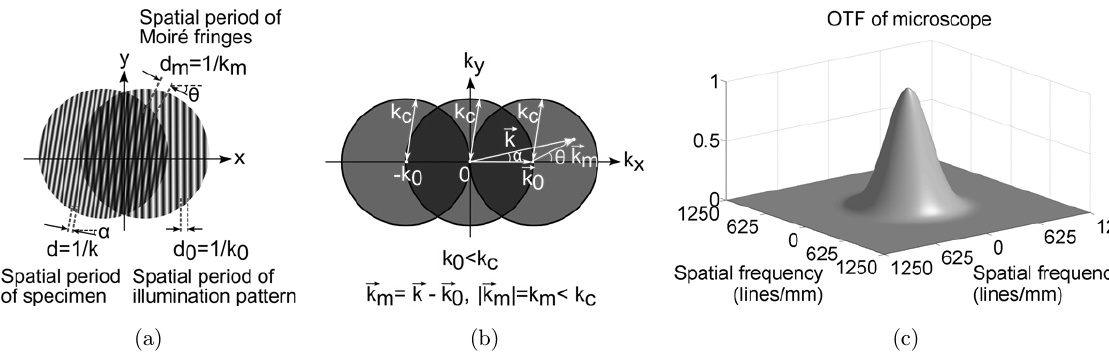
Fig. 4. Illustration of frequency encoding and decoding in SIM. (a) The moir (cid:1)e fringes generated by structured illumination; (b) the spectral extension in Fourier domain along one orientation and (c) 2D OTF pro¯le of a conventional